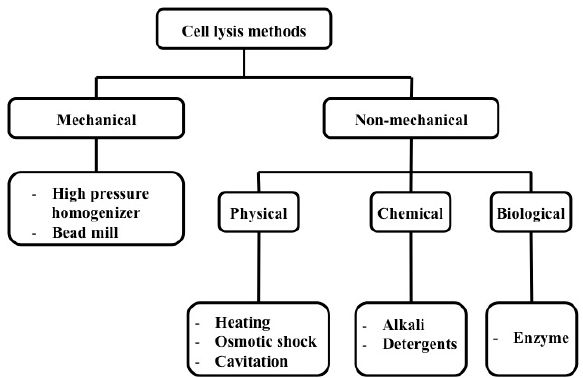
Figure 5. Classification of cell lysis methods.